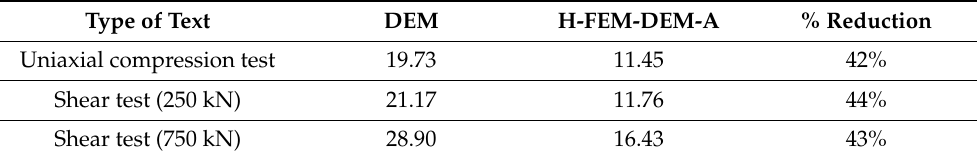
Figure 18. Shear test in rubble with initial precompression-force displacement diagrams. ( a ) 250 kN; ( b ) 750 kN. Table 5. Execution times (hours) for the rubble masonry wall